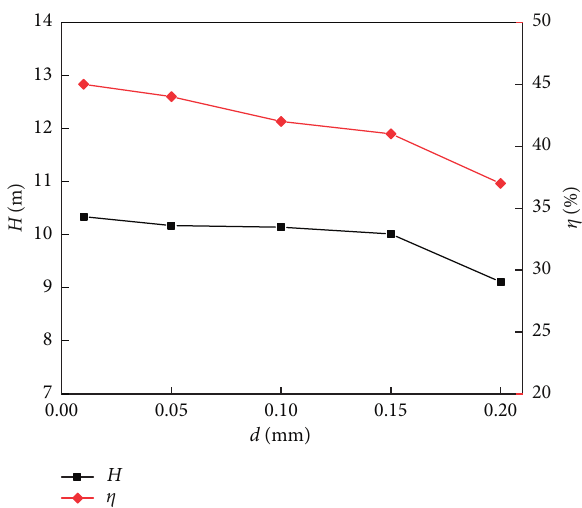
Figure 11: Influence of particle size on head and